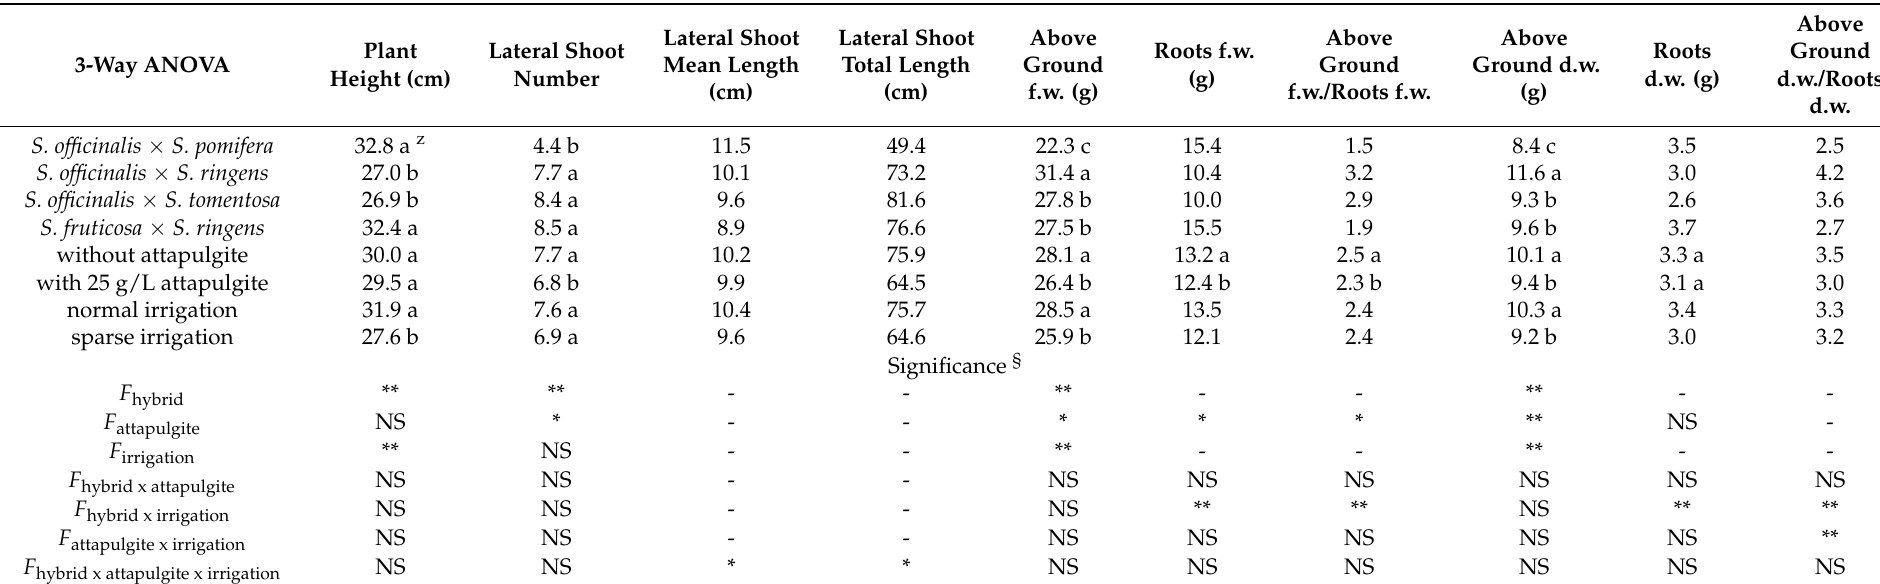
Table 3. The effect of the experimental factors, i.e., hybrid type ( S. officinalis × S. pomifera , S. officinalis × S. ringens , S. officinalis × S. tomentosa , S. fruticosa × S. ringens ), irrigation frequency (normal, sparse) and substrate type (with 25 g/L attapulgite, without attapulgite) on above ground and root system growth parameters of sage interspecific hybrids.